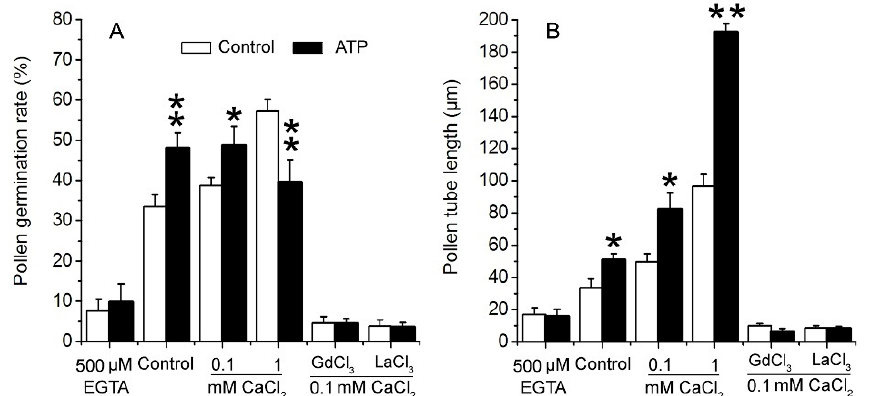
Figure 3. eATP regulates PG and PTG of Arabidopsis thaliana by facilitating Ca 2+ uptake. ATP (0.1 mM) regulates PG ( A ) and PTG ( B ) in medium containing a Ca 2+ chelator, serial concentrations of Ca 2+ , and channel blockers (0.1 mM). In each experiment, at least 300 pollen grains were counted to obtain PG, and at least 150 pollen tubes were measured to obtain the pollen tube length. Data